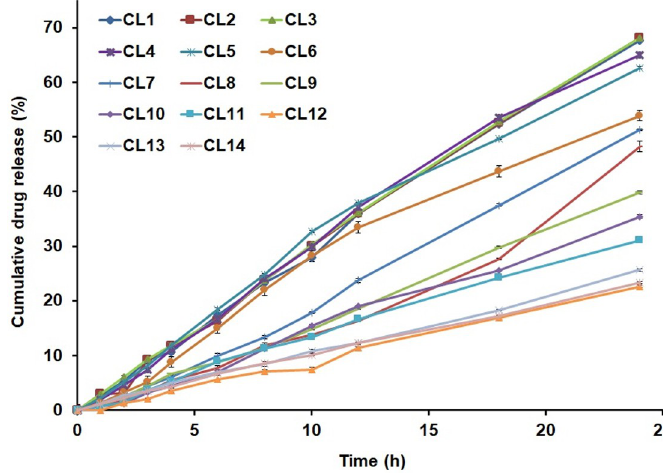
Fig 7. Comparative in-vitro drug release profiles of formulations CL1-CL14 over 24 h time period.